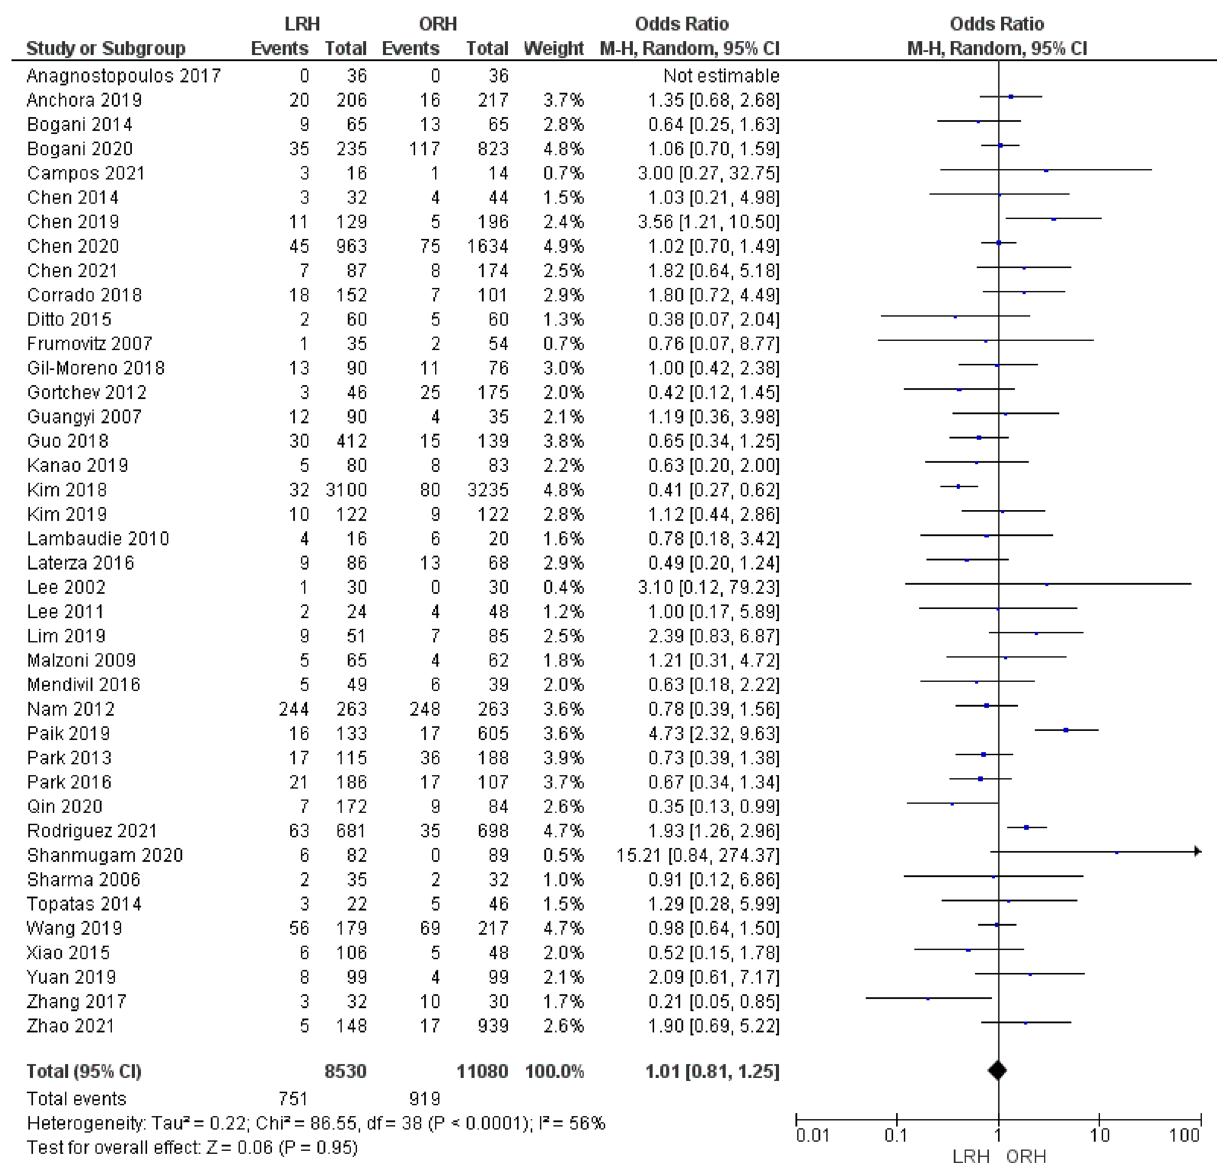
Figure 11. Forest plot of recurrence of